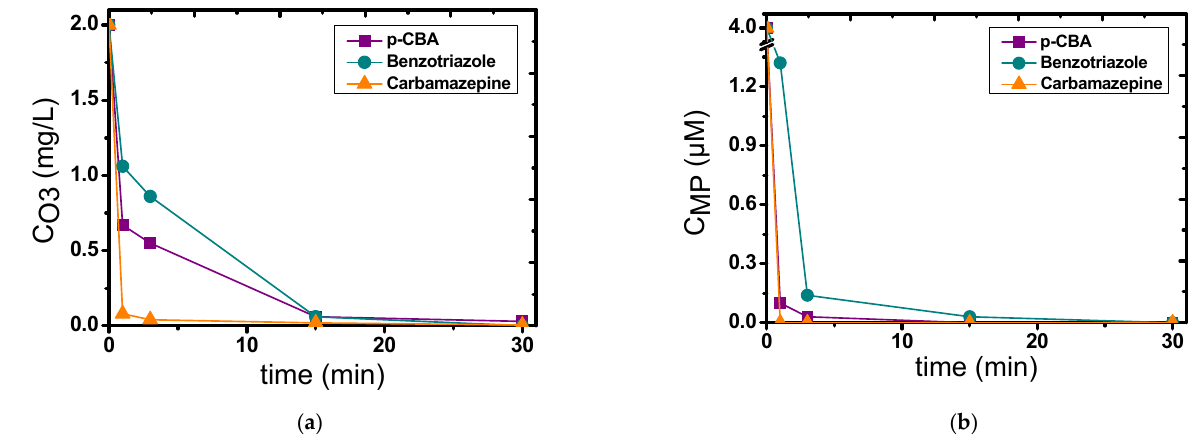
Figure 3. Removal of micropollutants during heterogeneous catalytic ozonation using zeolite-T as a catalyst: ( a ) ozone decomposition; ( b ) micropollutant removal. Experimental conditions: C MP 4 µ M, C O3 2 mg/L, C zeol. 0.5 g/L, pH 7, temperature 23 ± 2 °C.